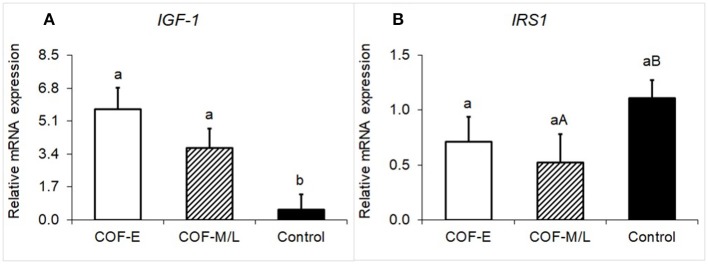
Fold-change in the mRNA expression for two energy metabolite genes (A)
IGF-1 and (B)
IRS1, detected in the follicular fluid in cows diagnosed with COF at early (COF-E) and mid-late (COF-M/L) lactation and the control cows. Different letters (a,b) represent different (P < 0.05) least-square means and capital letter (A,B) represent tendencies (0.05 < P ≤ 0.10). Error bars represent the mean standard error.